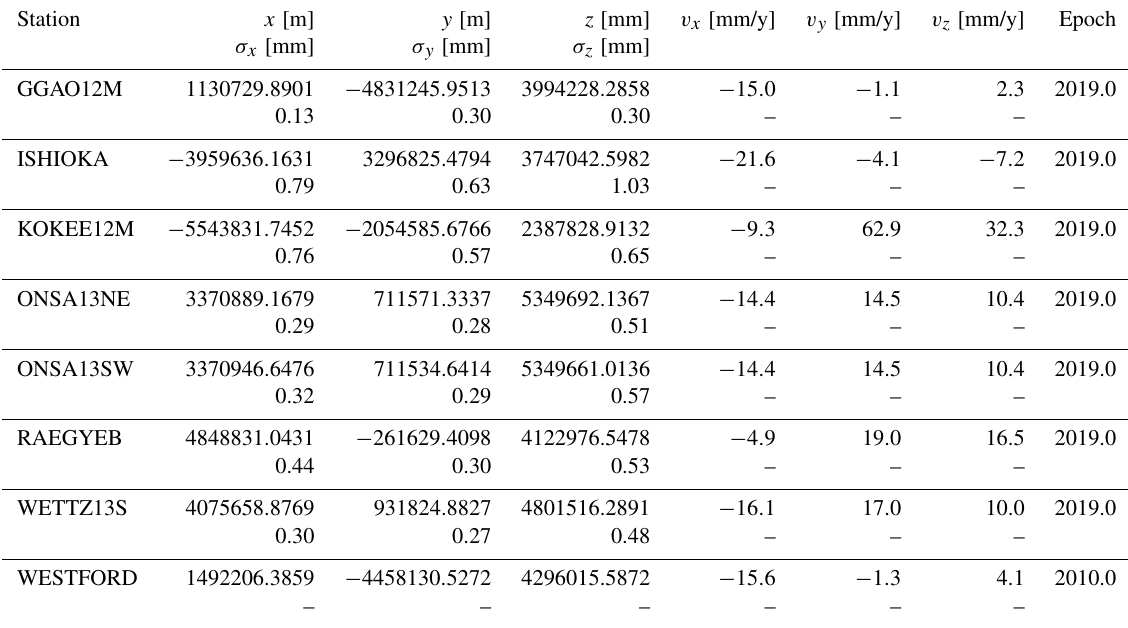
Table 5. The VGOS station coordinates resulting from the final global solution using the best parametrization for the tropospheric parameters and their formal uncertainties σ . The velocities v are taken from the ITRF2014 for co-located telescopes or were determined from X/S sessions in the case of